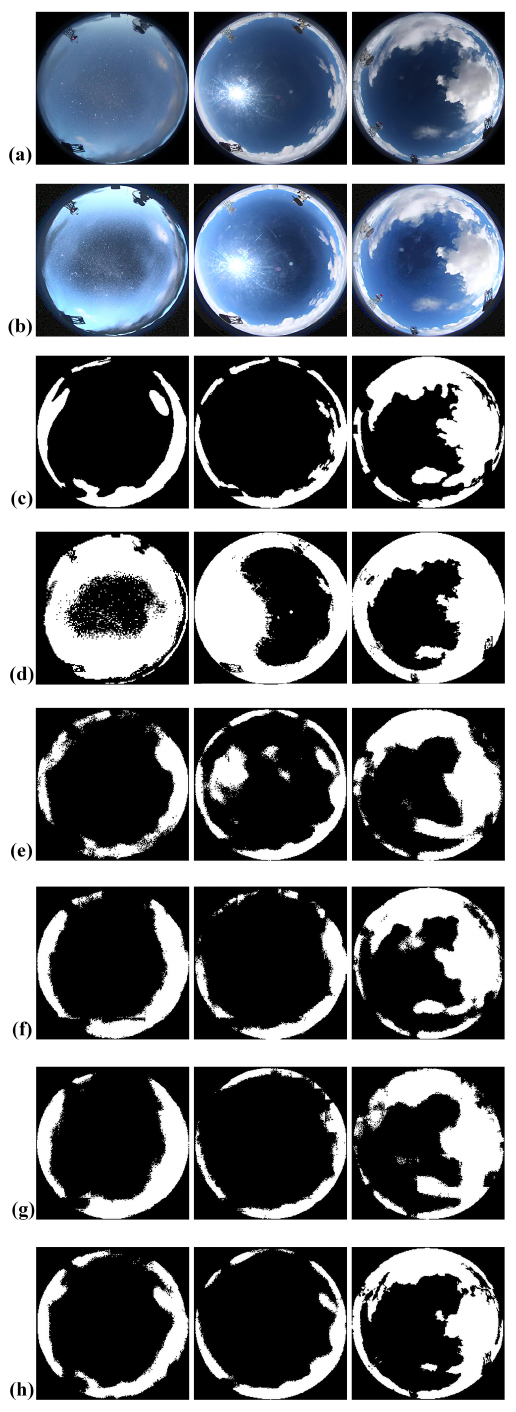
Figure 6. Results of different cloud segmentation algorithms. (a) Original diurnal ASI images, (b) enhanced diurnal ASI images, (c) ground truth of the corresponding ASI images in (a) , (d) results of OTSU, (e) results of EFCN-32s, (f) results of EFCN-16s, (g) re- sults of FCN-8s, and (h) results of the proposed EFCN-8s.